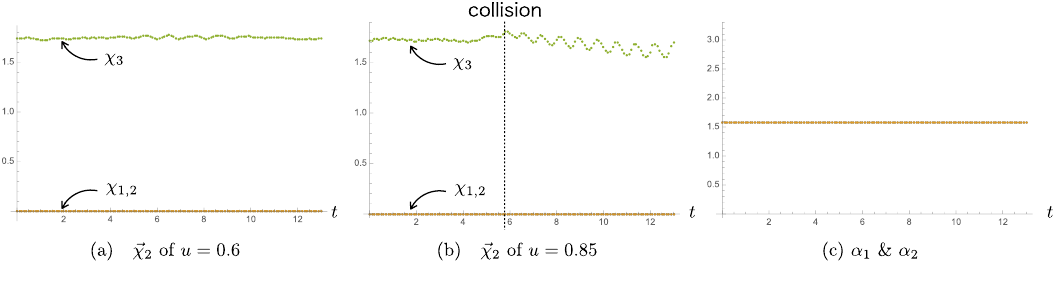
Figure 5 . Evolution of ~χ 2 = ~χ ( X 2 ( t ) , Y 2 ( t )) for u = 0 . 6 and u = 0 . 85 .